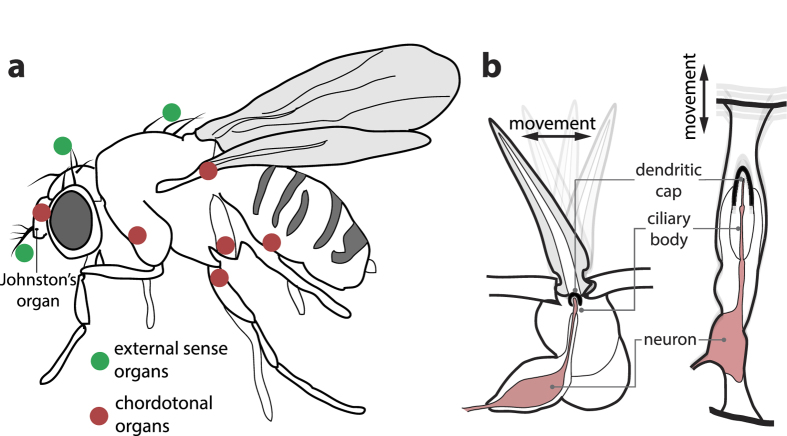
Sensory hair cells and chordotonal organs 18.(a) Locations of sensory hair cells (including the antennal receiver) and chordotonal organs in Drosophila. (b) Insect arista and chordotonal organs.